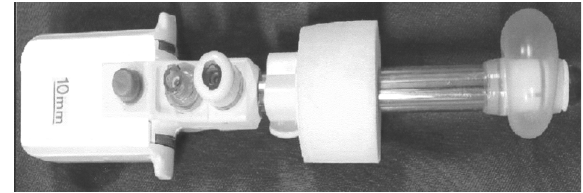
Figure 5 – Trocar with internal balloon and sponge that enables an excellent sealing of